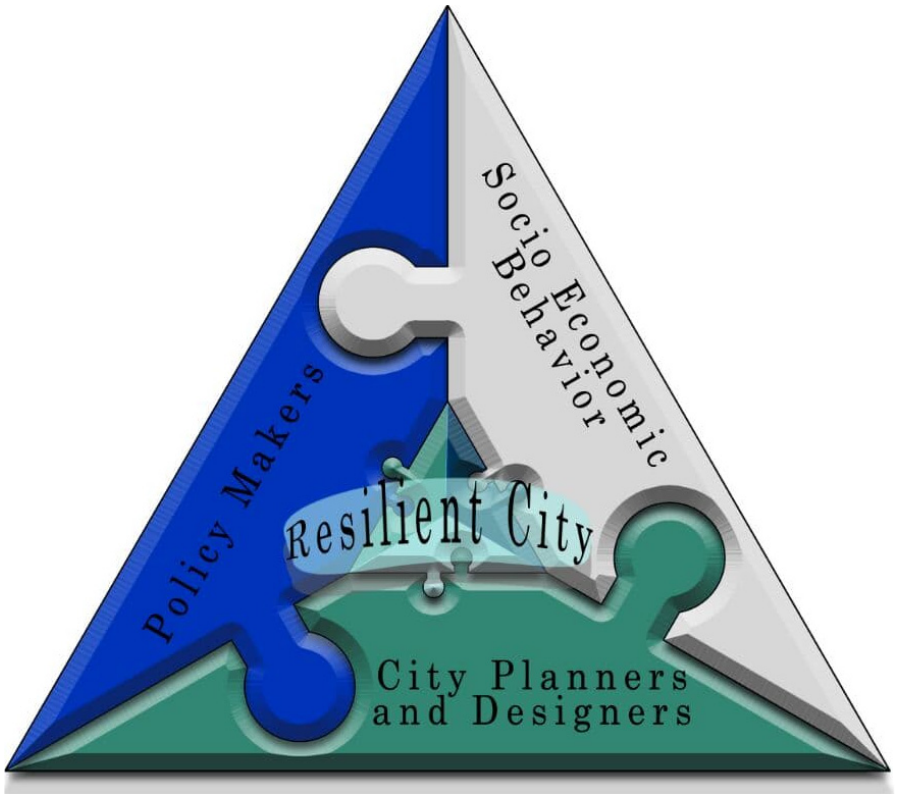
Figure 10. Ways of integration to combat pandemics; source: authors, 2022.